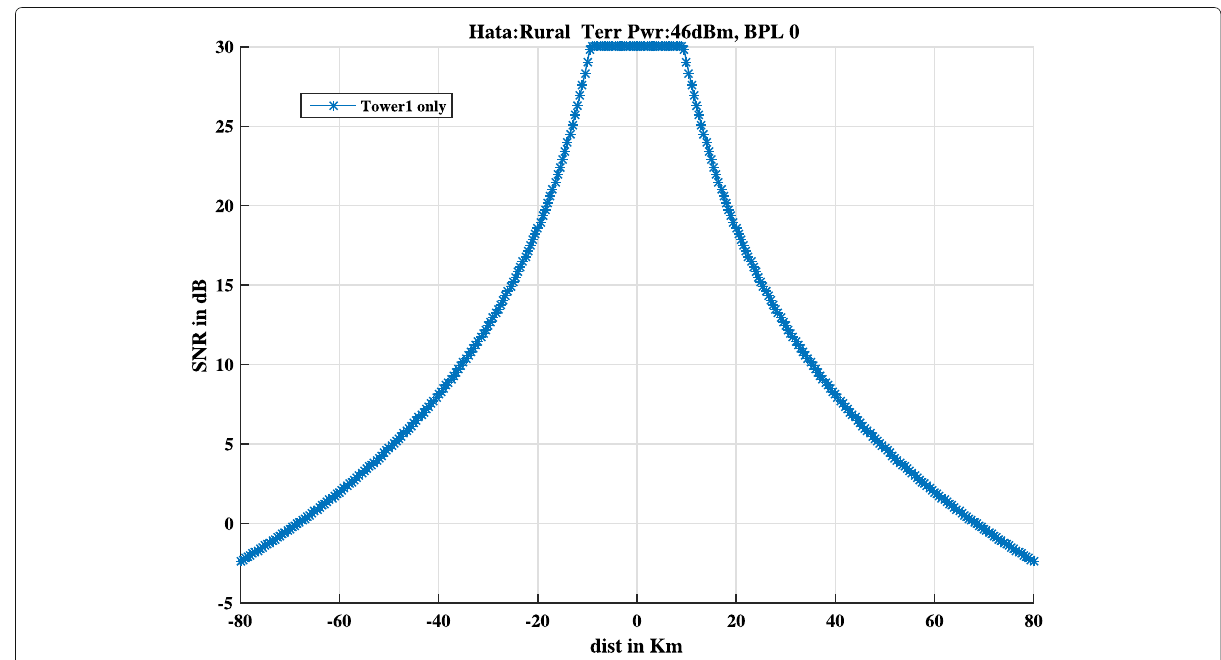
Fig. 3 Expected outdoor SINR with a single rural terrestrial tower The SINR from this scenario is shown in Fig. 6. In this case, there is minimal impact due to the Loon HAP while the outdoor coverage gain is still realized. Considering now a suburban case, Fig. 7 shows the two terrestrial towers spaced 3.76 km apart for outdoor UEs, still with 100% load on the Loon eNB.